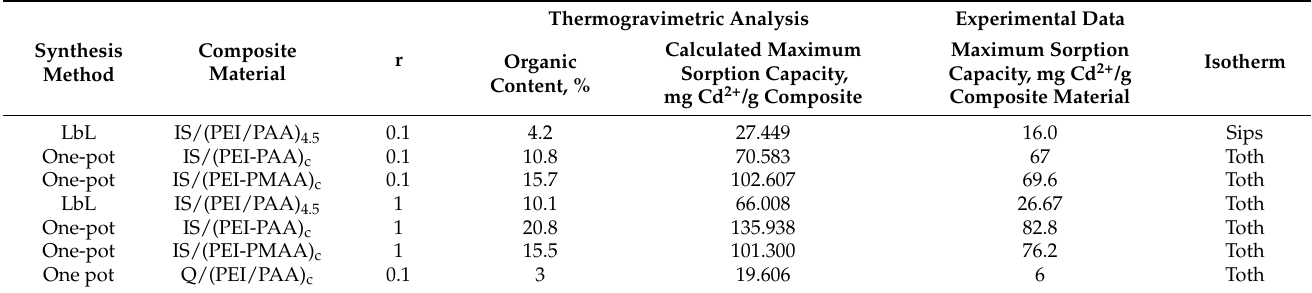
Table 1. Synthesis routes and experimental data (adapted from